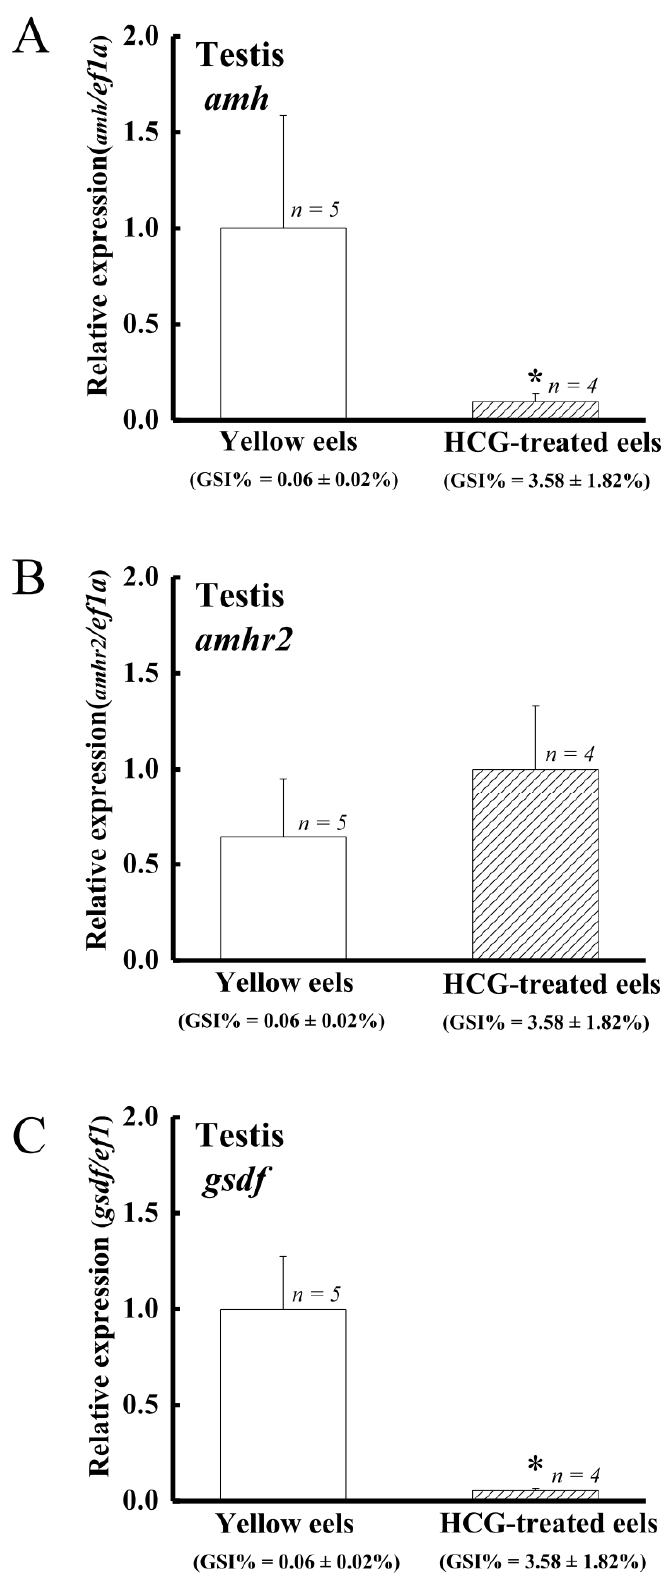
Figure 6. Profiles of ( A ) amh , ( B ) amhr2 , and ( C ) gsdf expression in the control and HCG-treated male Japanese eels. Transcripts were measured by qPCR. ef1a was used as an internal control gene. Data were expressed as means ± SEM. Asterisks indicate significant differences (* p < 0.05) between the control male eels and HCG-treated male Japanese eels.